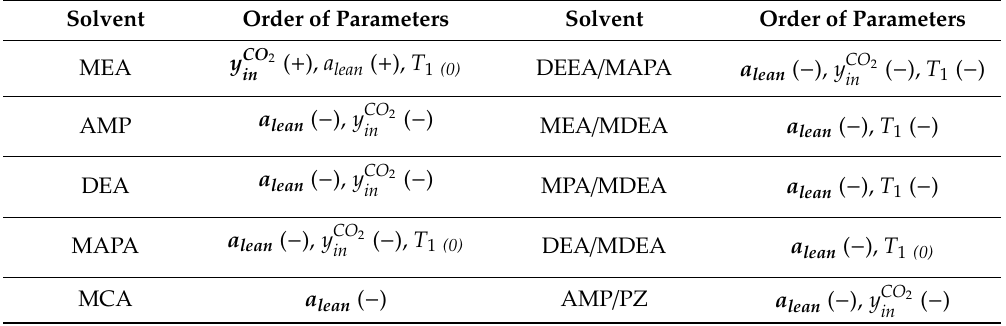
Table 6. Ranking of the parameters that a ff ected the performance indices of NEP , m am , and ∆ α